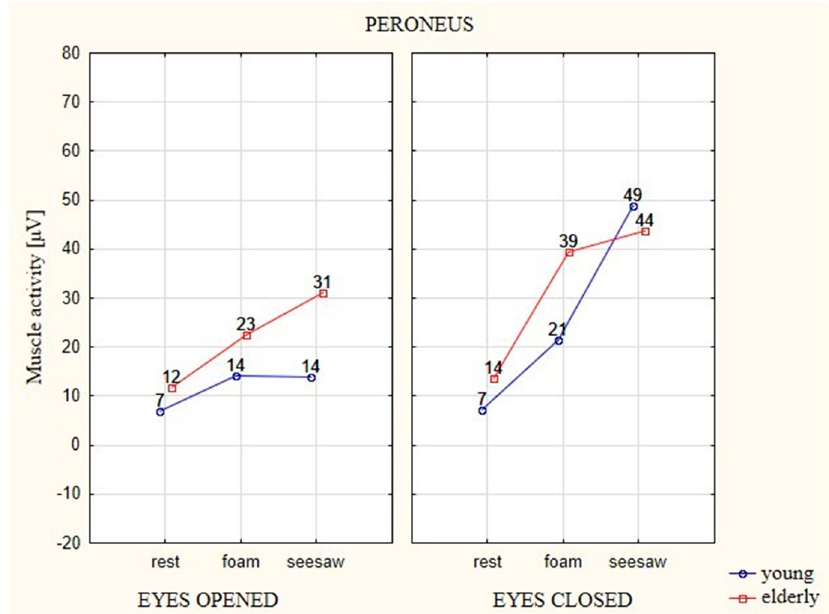
Figure 6. The average EMG values of the PL muscle in elderly and young participants on different types of surface and with EO (eyes 1) and EC (eyes 2).